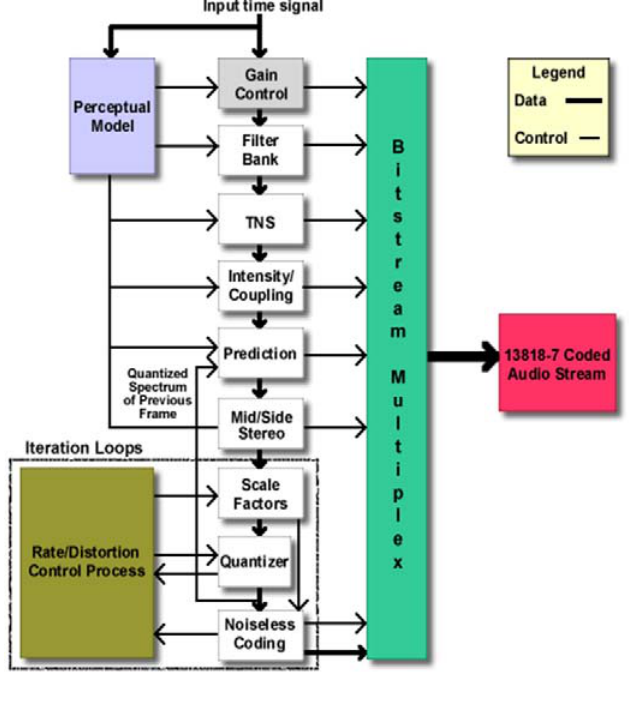
Figure 1. AAC flowing chart